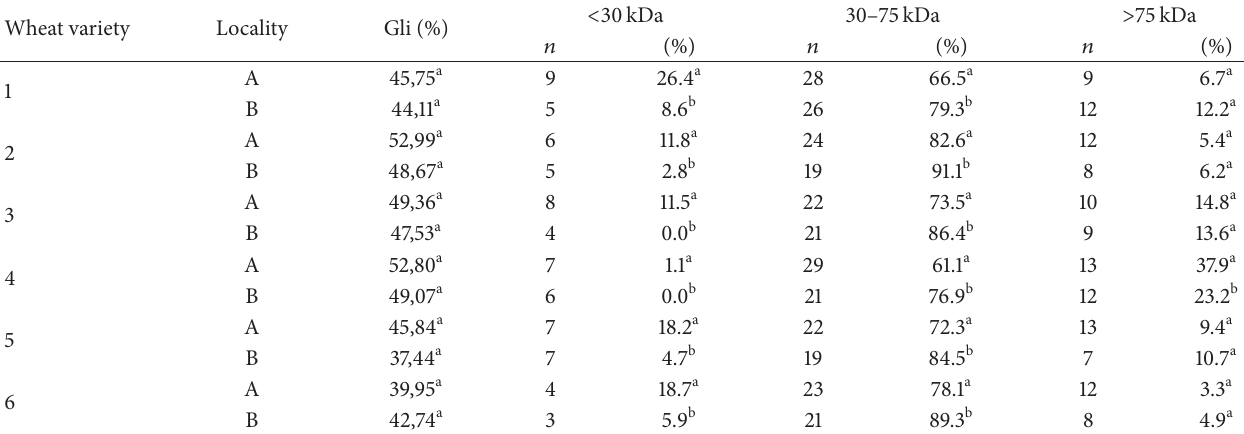
Table 3: The number of bands and relative amount of gliadin fractions within the selected molecular weight ranges for wheat varieties from observed localities.